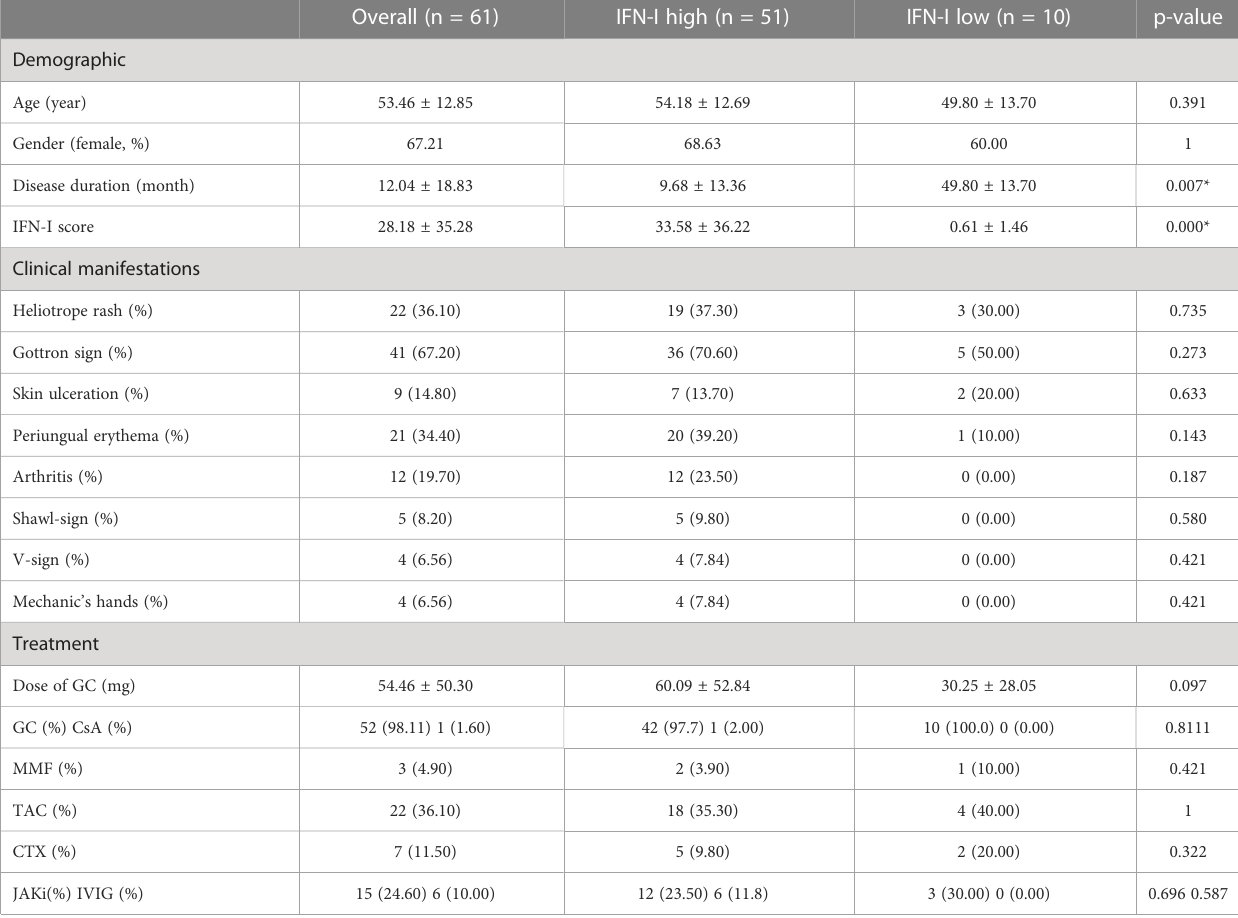
TABLE 1 Baseline characteristics of patients with anti-MDA5+ DM and comparisons between the high and low IFN-I score